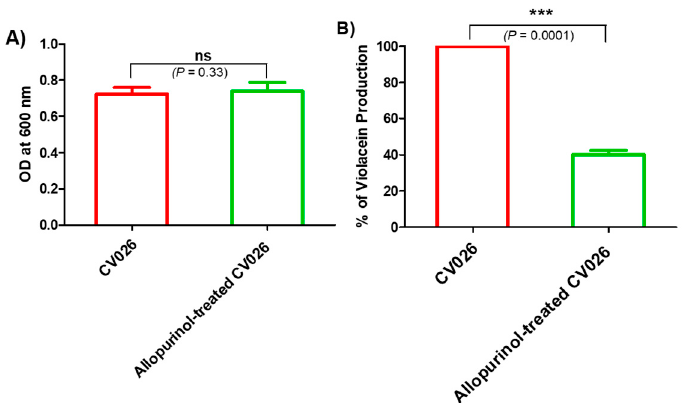
Figure 2. Effect of allopurinol on ( A ) C. violaceum CV026 growth. The turbidities of overnight bacterial cultures in the absence or presence of 1/10 MIC of allopurinol were measured at OD 600 nm. Allopurinol had no significant effect on bacterial growth. ( B ) Violacein pigment production: violacein was extracted by DMSO from the bacterial cells treated with or without 1/10 MIC of allopurinol. Allopurinol significantly reduced violacein